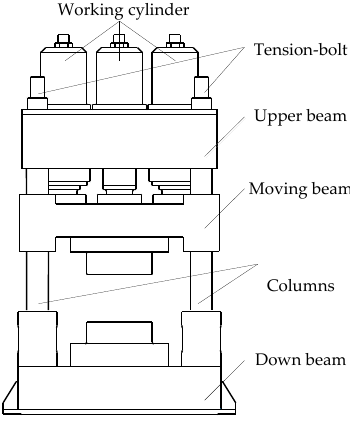
Figure 2. The frame diagram of the hydraulic press.